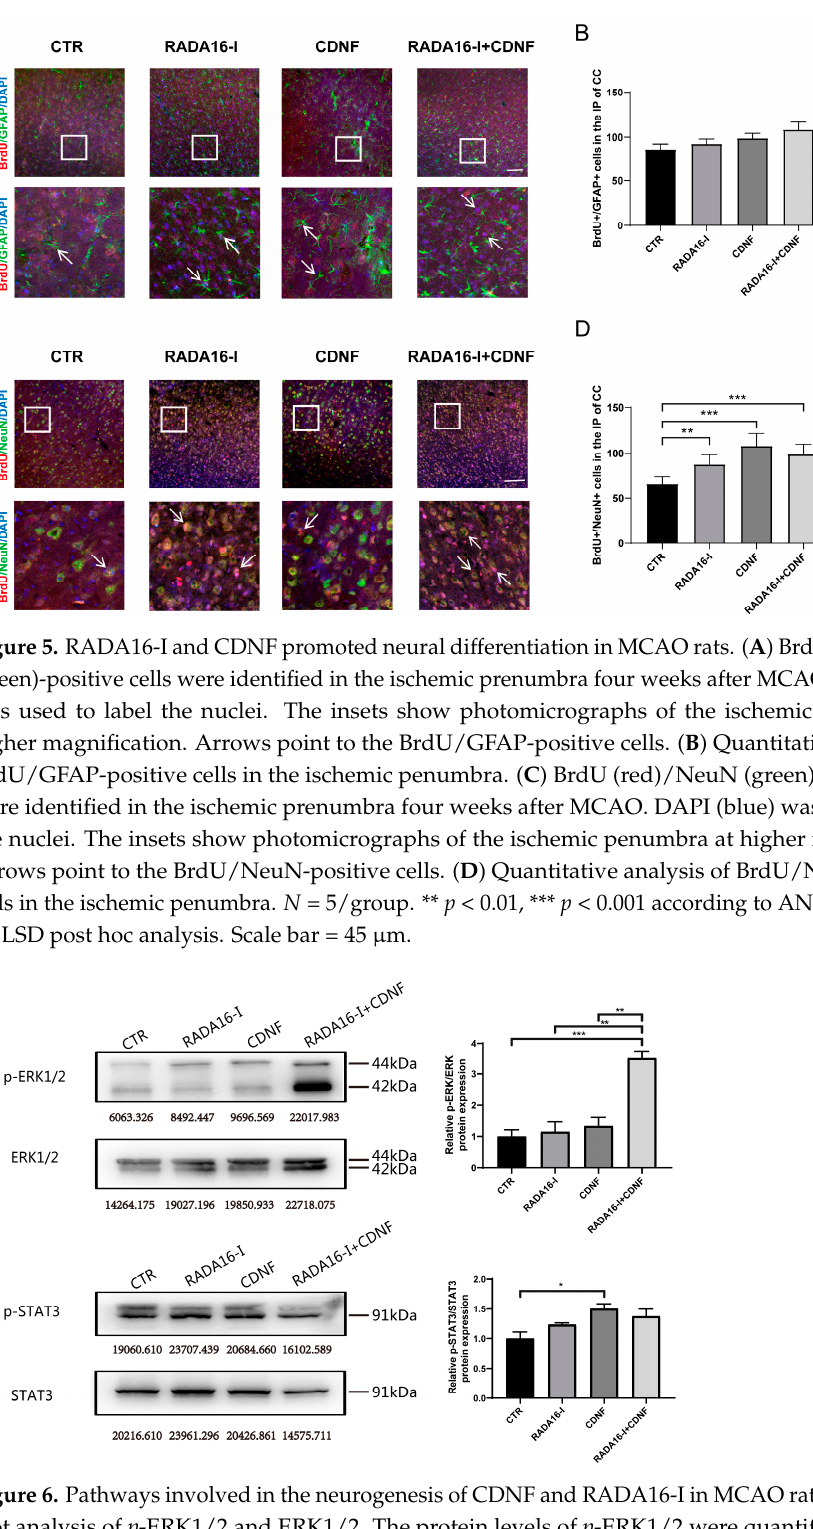
Figure 6. Pathways involved in the neurogenesis of CDNF and RADA16-I in MCAO rats. ( A ) Western blot analysis of p -ERK1/2 and ERK1/2. The protein levels of p -ERK1/2 were quantified relative to the level of ERK1/2. N = 4/group. ( B ) Levels of p -STAT3-Ser727 and STAT3 were deter- mined with use of Western blotting. The protein levels of p -STAT3-Ser727 were quantified relative to the level of STAT3. N = 4/group. * p < 0.05, ** p < 0.01, *** p < 0.001 according to ANOVA followed by LSD post hoc